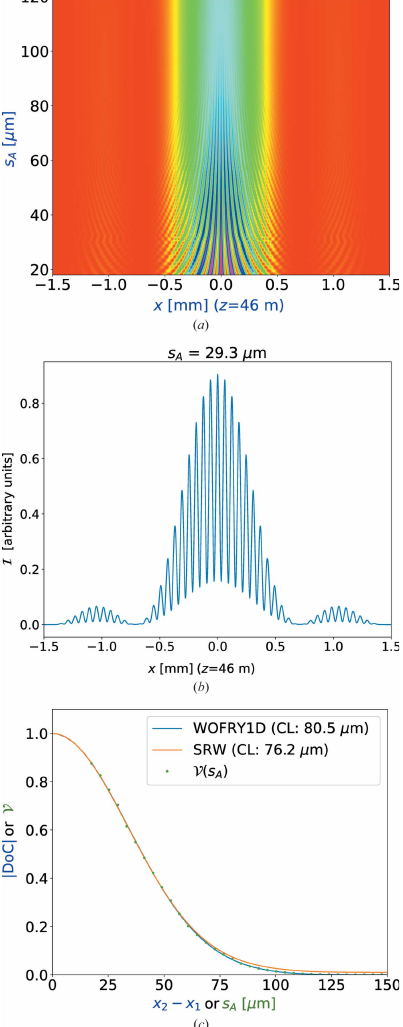
Figure 6 Simulation of beam propagation after a double-slit at 7 keV: ( a ) pattern intensity Ið x Þ at z = 46 m versus the separation s A between the slits. ( b ) Intensity profile Ið x ; z = 46 m) for slit separation s = 29.3 m m. ( c ) Modulus of the degree of coherence calculated from the profiles of Fig. 5 (top row), compared with the value obtained from the visibility extracted from ( a